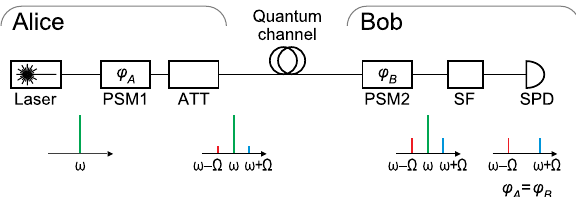
Figure 1. Basic subcarrier-wave QKD scheme. Plots show optical spectra at different points in the setup. ATT optical attenuator, PSM electro-optical phase shift modulator, SF notch spectral filter, SPD single-photon